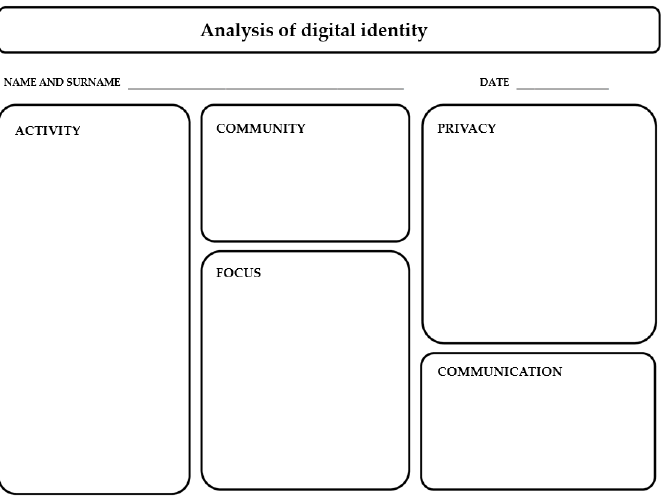
Figure 2. Canvas analysis of digital identity [21].